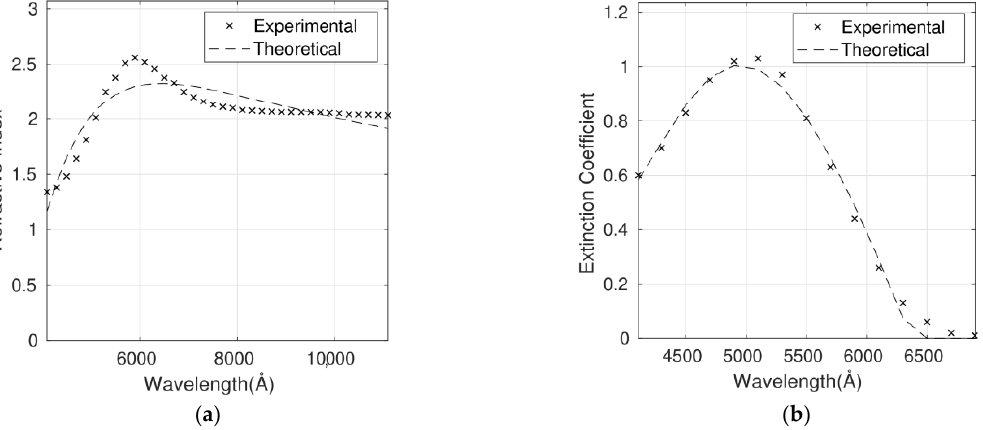
Figure 8. Refractive index ( a ) and extinction coefficient ( b ) fits to Cauchy’s equation for the P3HT/G (3 wt%) nanocomposite. Experimental data are adapted from Ref. [9] with permission from the American Institute of Physics, 2012.